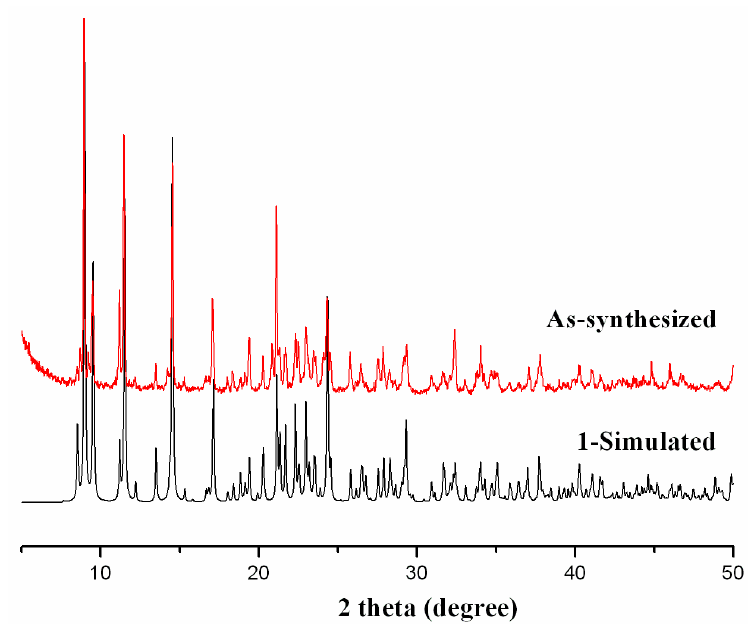
Figure 6. Simulated and experimental XRPD patterns of supramolecular polymer 1 .